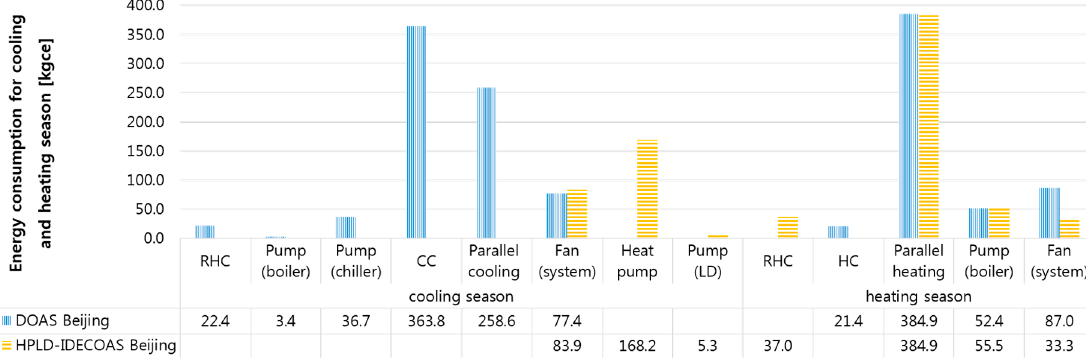
Figure 19. Comparison of seasonal energy consumption in Beijing.